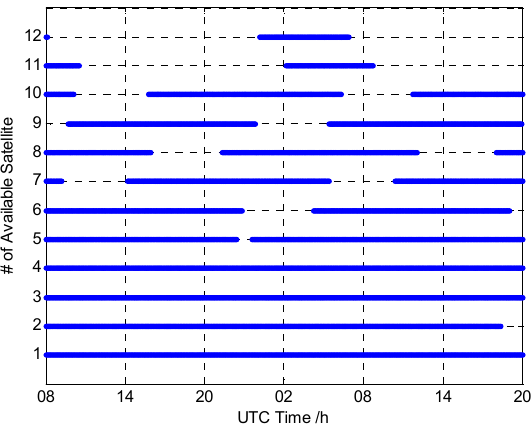
Figure 7. The available satellites of the collected data.